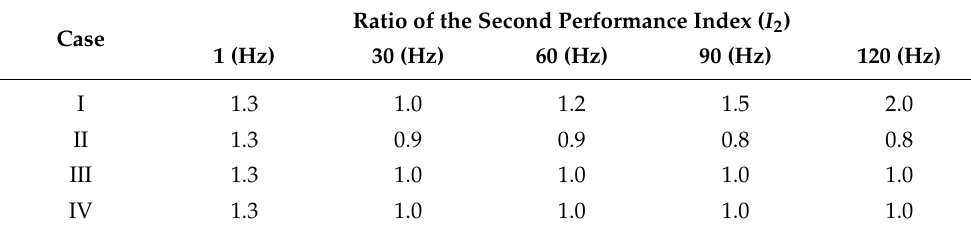
Table 4. Ratio of the second performance index for four vibration isolator